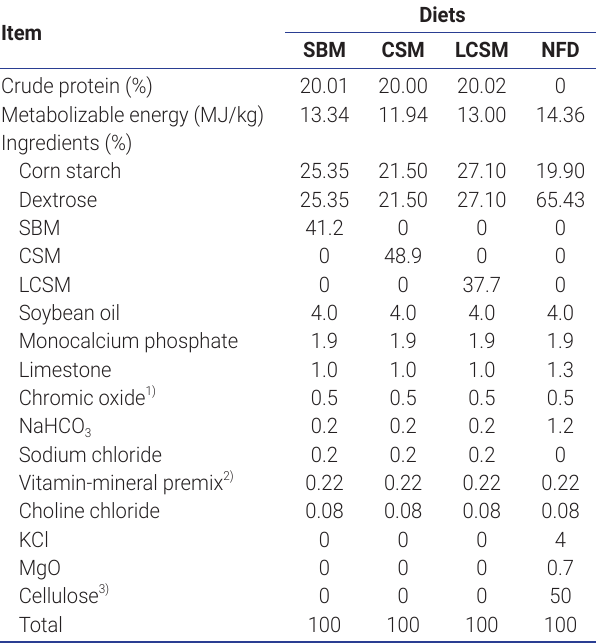
Table 3. Ingredient composition of experimental diets, as-fed